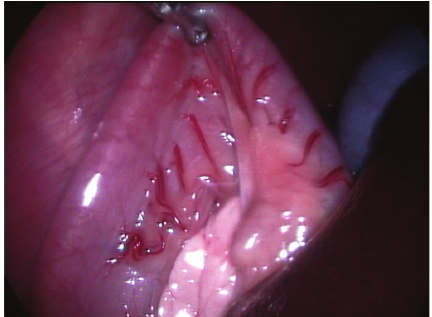
Figure 4: Left lateral capnoperitoneograph enhancing visualization of right liver lobes and diaphragmatic border in 8-year-old male Dobermann Pinscher dog demonstrating classical signs of pulmonary metastasis with strong suspicion for hepatic neoplasia.